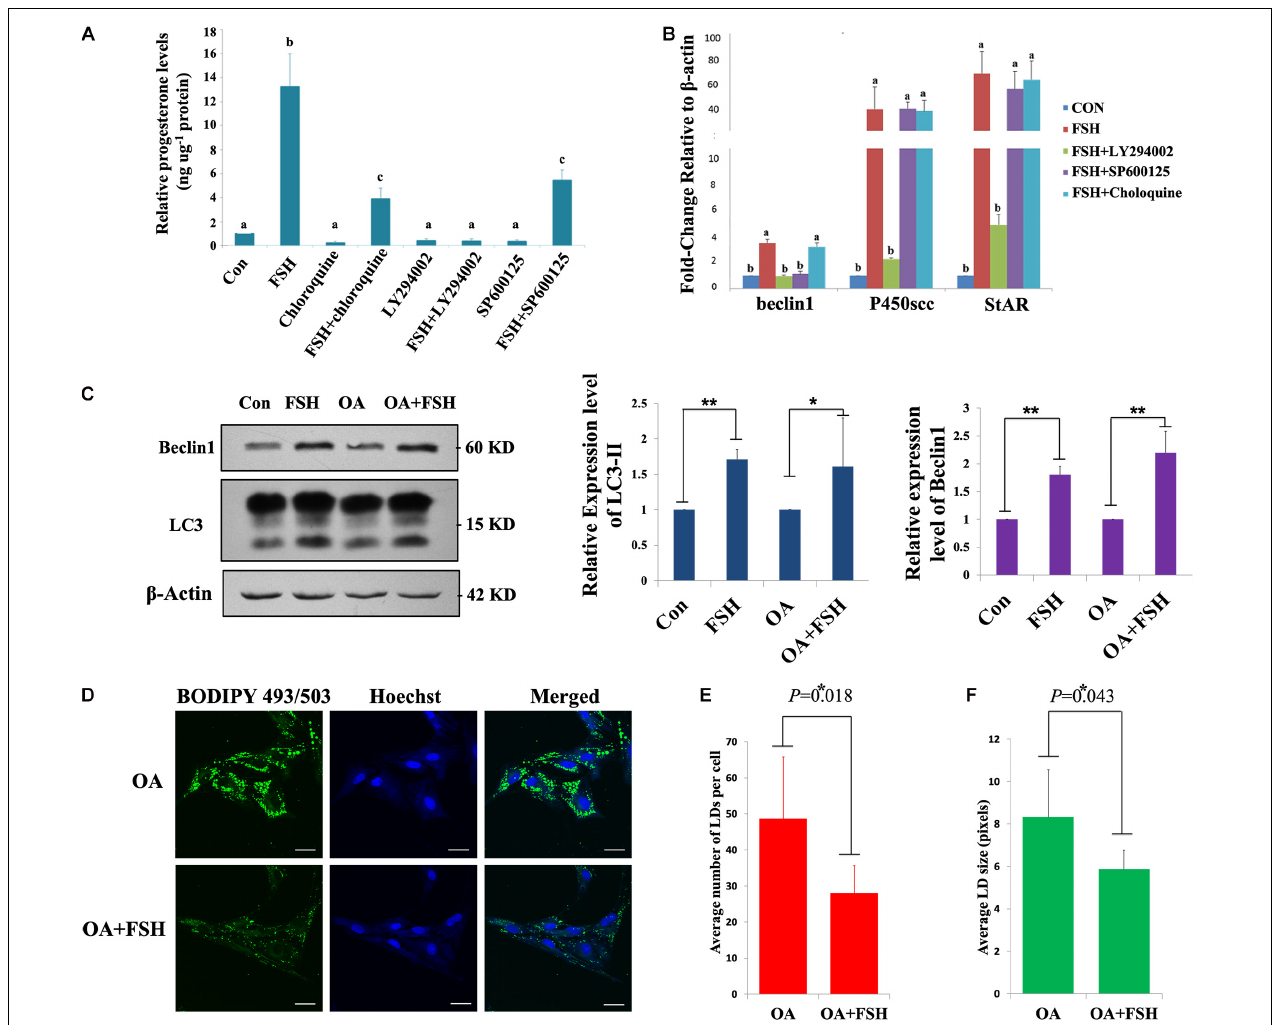
FIGURE 4 | Autophagy participates in progesterone production and lipid droplet metabolism upon FSH treatment in porcine GC mass. (A) Specific inhibitors of autophagy (chloroquine; 10 µ M), PI3K/AKT (LY294002; 10 µ M), and SAPK/JNK (SP600125; 10 µ M) were added 1 h before treatment with 0.01 IU/mL FSH for 24 h in GC mass. The cells and culture medium were collected separately. The total proteins were extracted from the cells and quantified using the BCA method. The concentration of progesterone in the culture medium was analyzed using radioimmunoassay. The relative progesterone level in the culture medium was calculated as ng/ µ g protein. Different superscripts (a, b, c) indicate significant differences ( P < 0.05) (B) Specific inhibitors of autophagy (chloroquine; 10 µ M), PI3K/AKT (LY294002; 10 µ M), and SAPK/JNK (SP600125; 10 µ M) were added 1 h before treatment with 0.01 IU/ml FSH for 24 h in GC mass. Total RNA was extracted from the cells, reverse transcribed to cDNA, and analyzed by real-time PCR with primers against beclin1 , StAR , and P450scc . (C) Adherent granulosa cells of the porcine ovary were cultured in DMEM/F12 serum-free medium with or without oleic acid (0.5 mM) for 12 h, and then cultured in DMEM/F12 serum-free medium with FSH (0.01 IU/mL) or with FSH and OA (0.5 mM) for 24 h. β -actin, LC3-II, and Beclin 1 levels were detected by western blotting. (D) BODIPY 493/503 LD staining of adherent granulosa cells after treatment with OA and FSH; Hoechst 33342 staining of the cell nuclei, Bars: 30 µ m. (E) The average number of LDs per granulosa